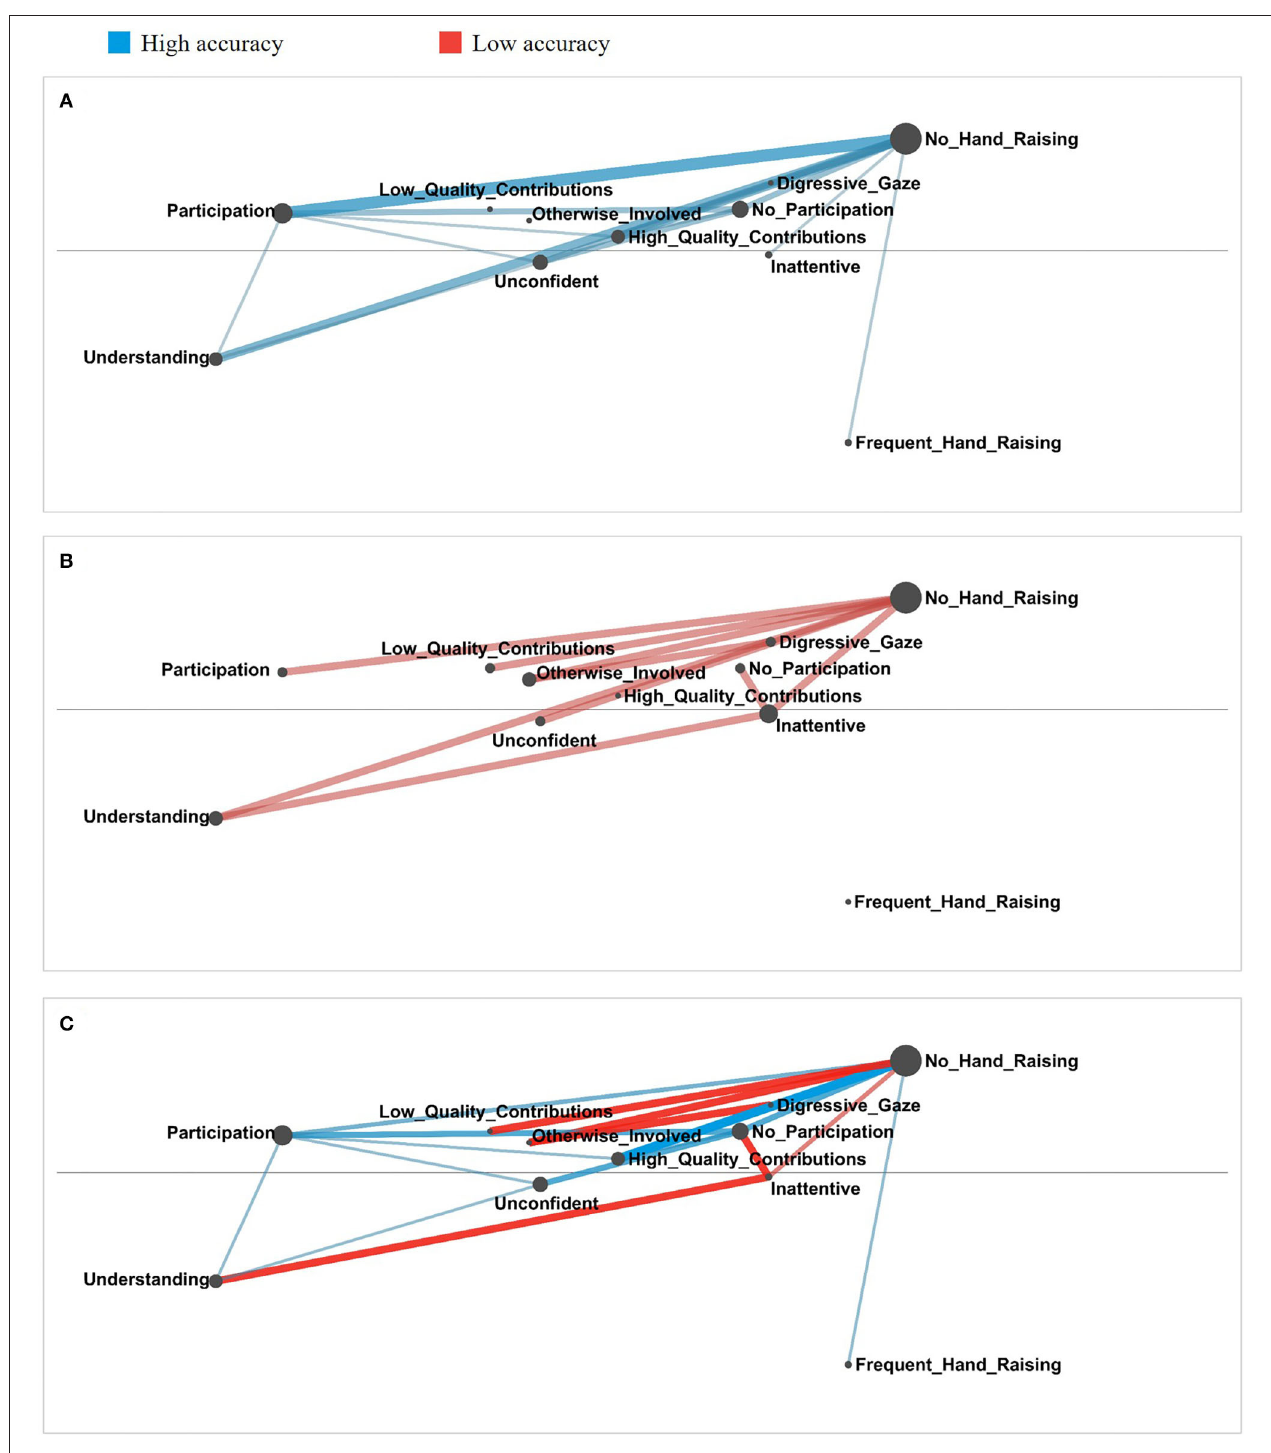
FIGURE 10 | Comparison of networks for underestimating student profile between student teachers with high and low judgment accuracy. (A) Depicts the network of the underestimating student profile for student teachers with high accuracy. (B) Depicts the network of the underestimating student profile for student teachers with low accuracy. (C) Shows the comparison of both networks. Here, the color of connections indicates which group utilized the respective code combination more frequently. In order to make the characteristics of the individual networks clearly visible and to make the differences visually easier to recognize, minimum edge weight and scale for edge weight were set to 0.1 and 1.3,